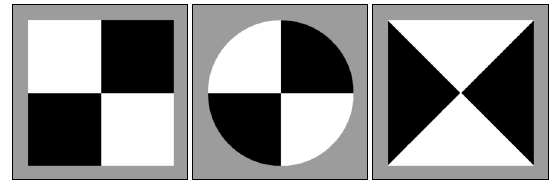
Figure 2. Considered types of control